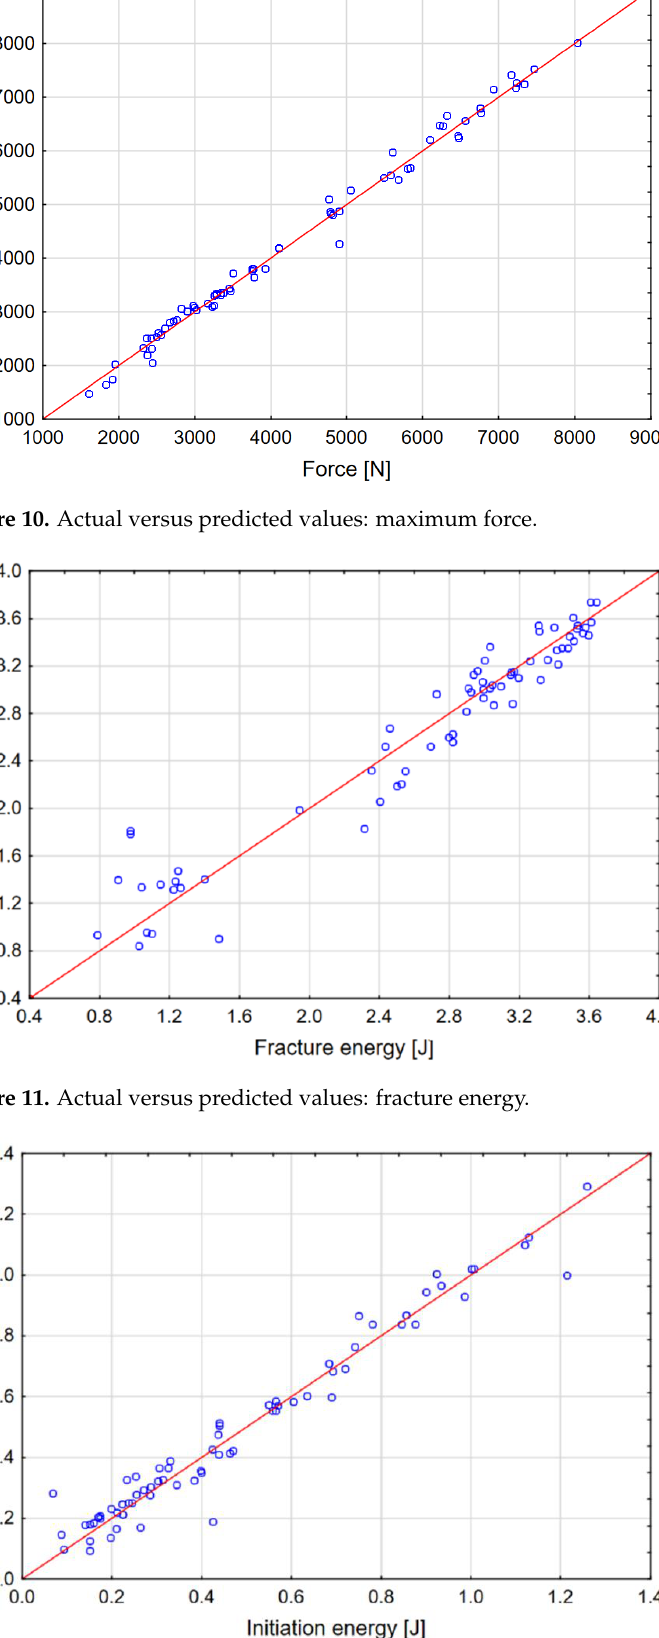
Figure 12. Actual versus predicted values: initiation energy.